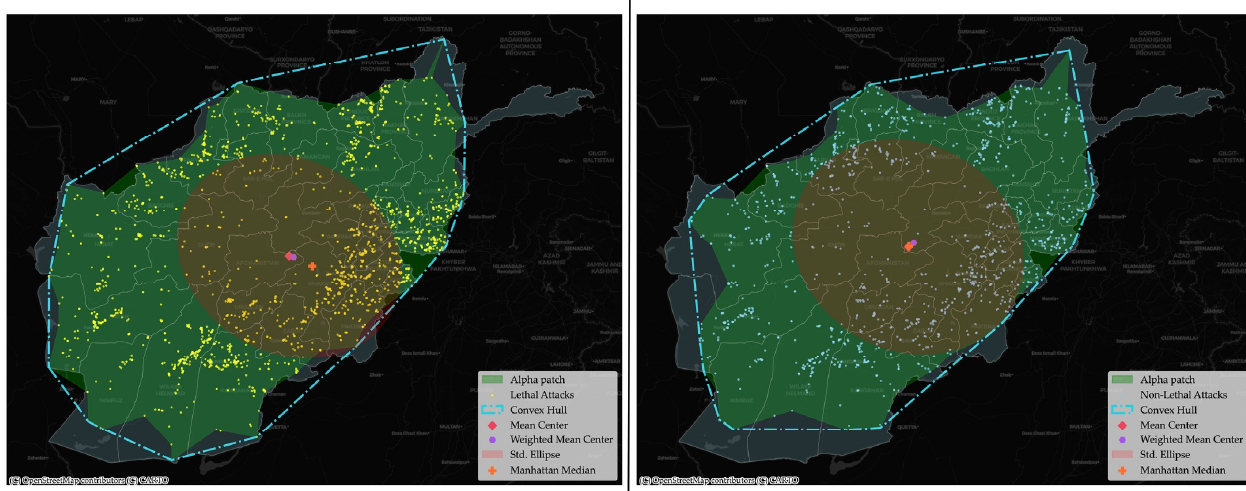
Figure 2. Exploratory spatial data analysis of the lethal and non-lethal attacks in Afghanistan. The Manhattan median, represented by a cross sign in Figure 2 for lethal and non- lethal attacks, is located at (33.69, 67.65) degrees and (34.12, 66.79) degrees. In contrast with the non-lethal attacks, the Manhattan median is significantly farther away from the mean and weighted mean center of lethal attacks. The standard deviation ellipse is almost similar for the location of the spatial attack in Afghanistan with a similar 60 ◦ rotation in the clockwise direction representing that both lethal and non-lethal attacks have similar geographical dispersion. The large standard deviation ellipses represent huge dispersion in the